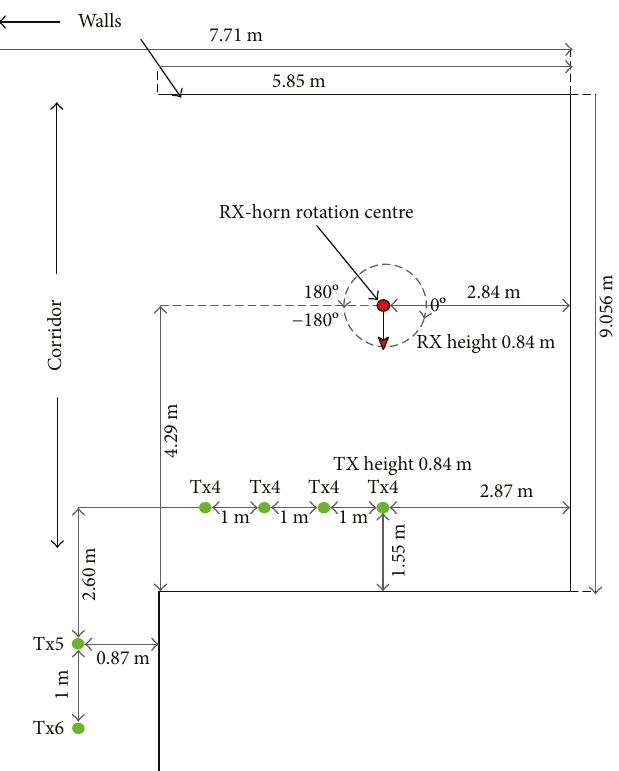
Figure 3: Empty basement scenario.